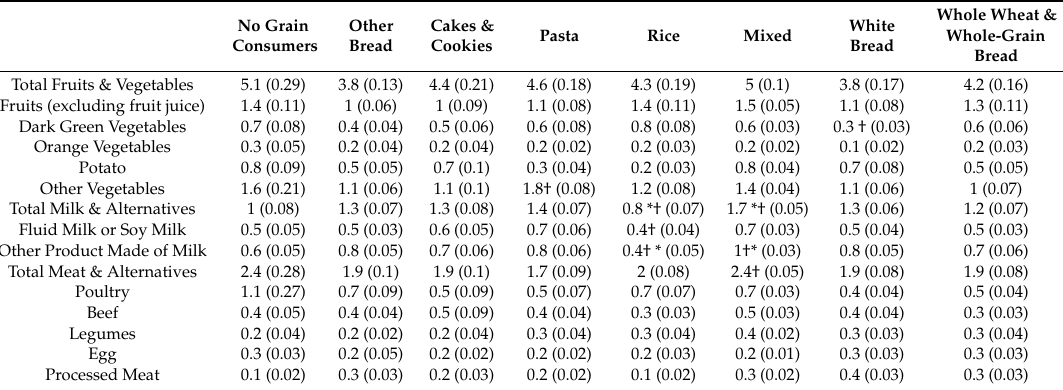
Table 3. The average intake of food group servings consumed in identified